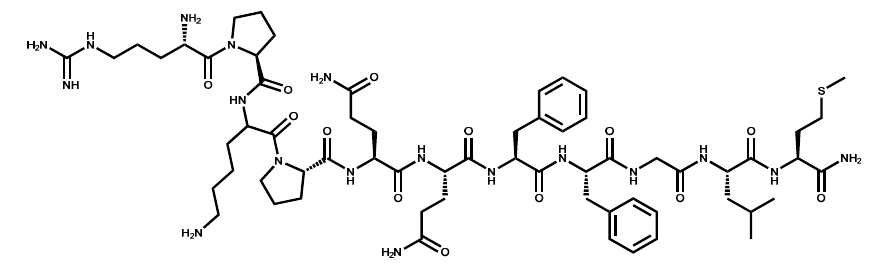
Figure 1. Chemical structure of substance P.